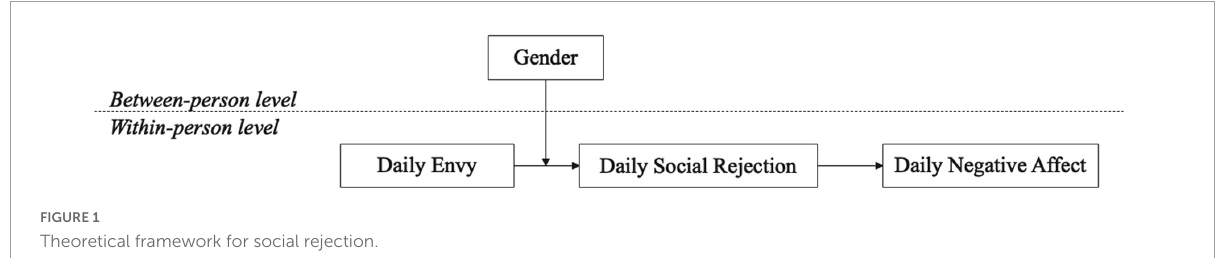
(Lee and Duffy, 2019; Yang and Tang, 2021; Montal-Rosenberg and Moran,